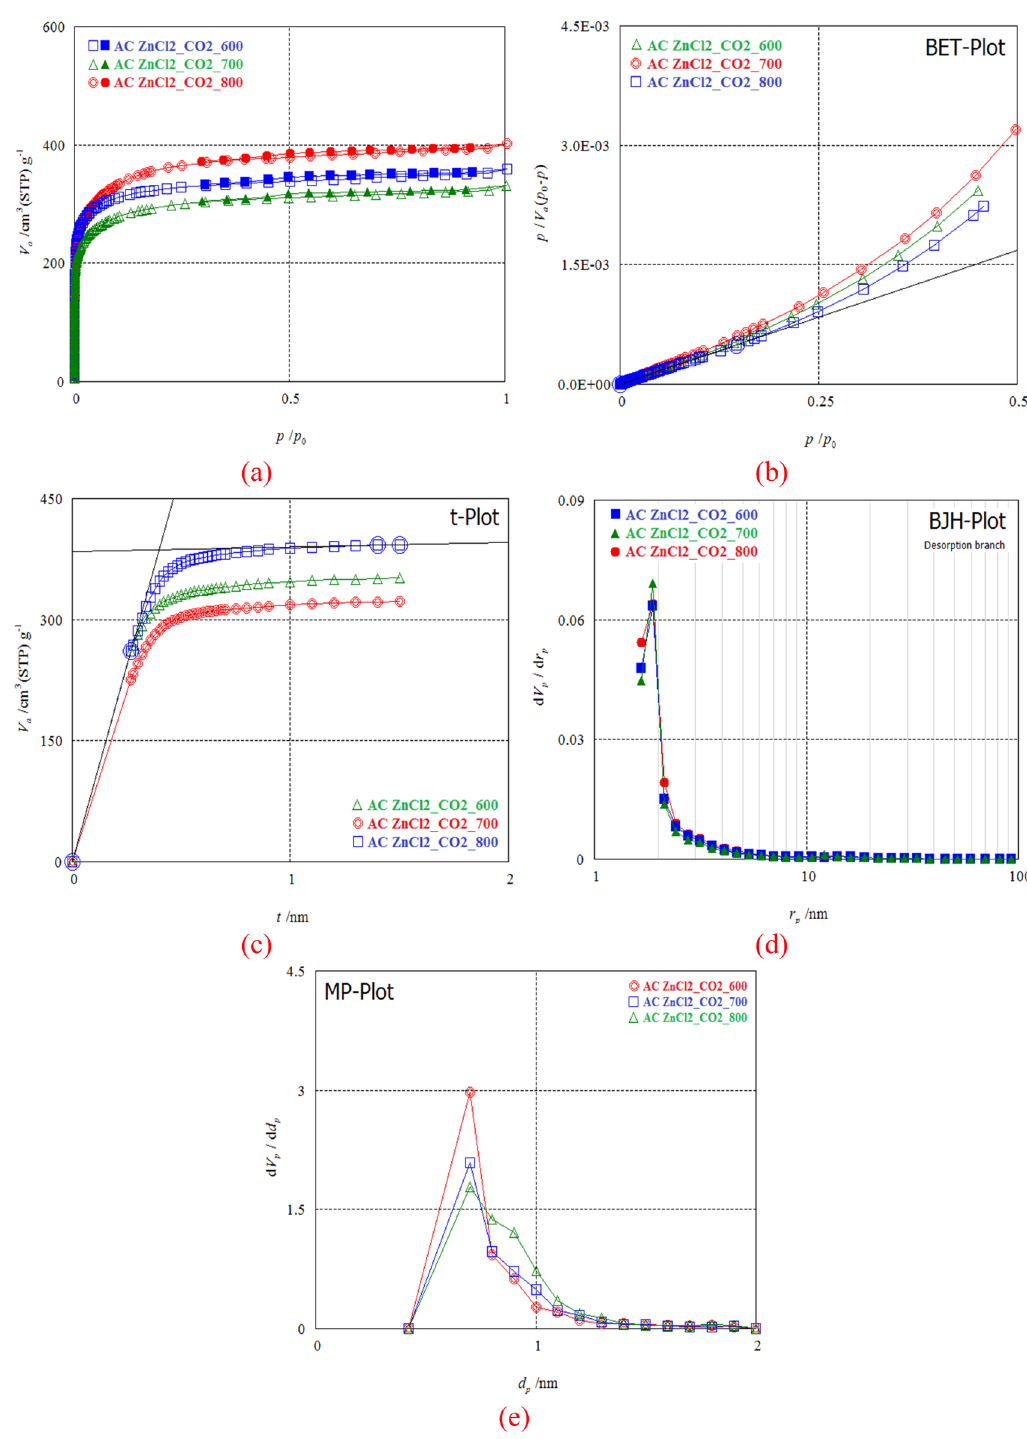
Figure 5. Analysis of PPAC surface area ( a ) Adsorption/desorption under N 2 gas, ( b ) analysis with BET; ( c ) analysis with t -plot; ( d ) analysis with BJH, ( e ) analysis with